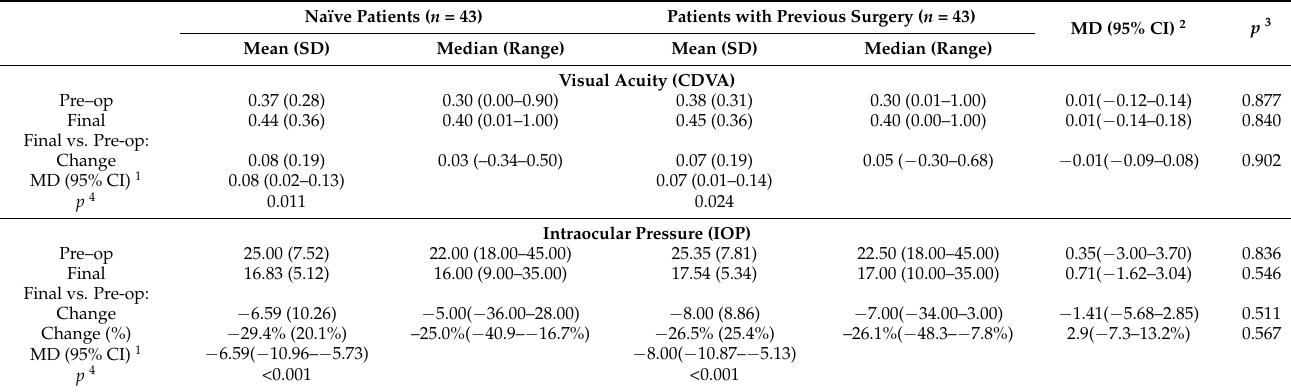
Table 2. Visual acuity and interocular pressure mean values, median values, standard deviations, and range before and after surgery.